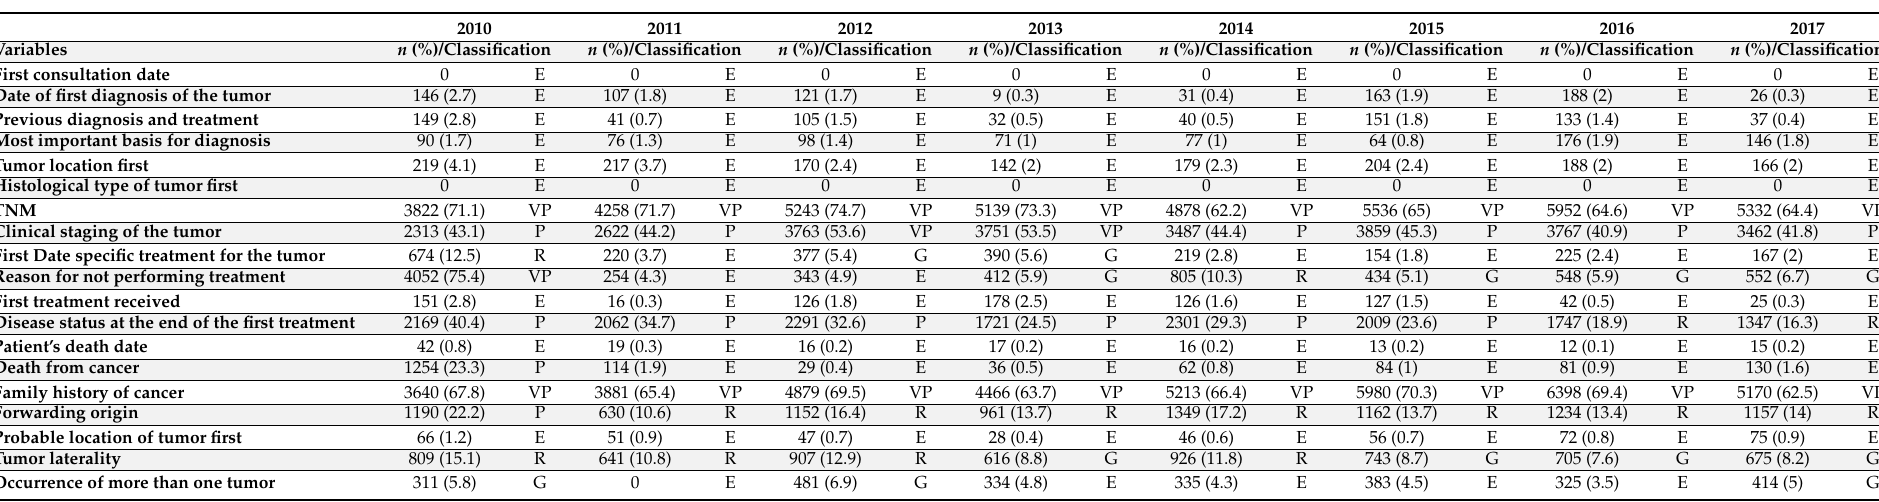
Table 3. Absolute frequency and percentage of missing HCR data and classification of completeness of clinical variables from 2010 to 2017. Vit ó ria, ES, Brazil.